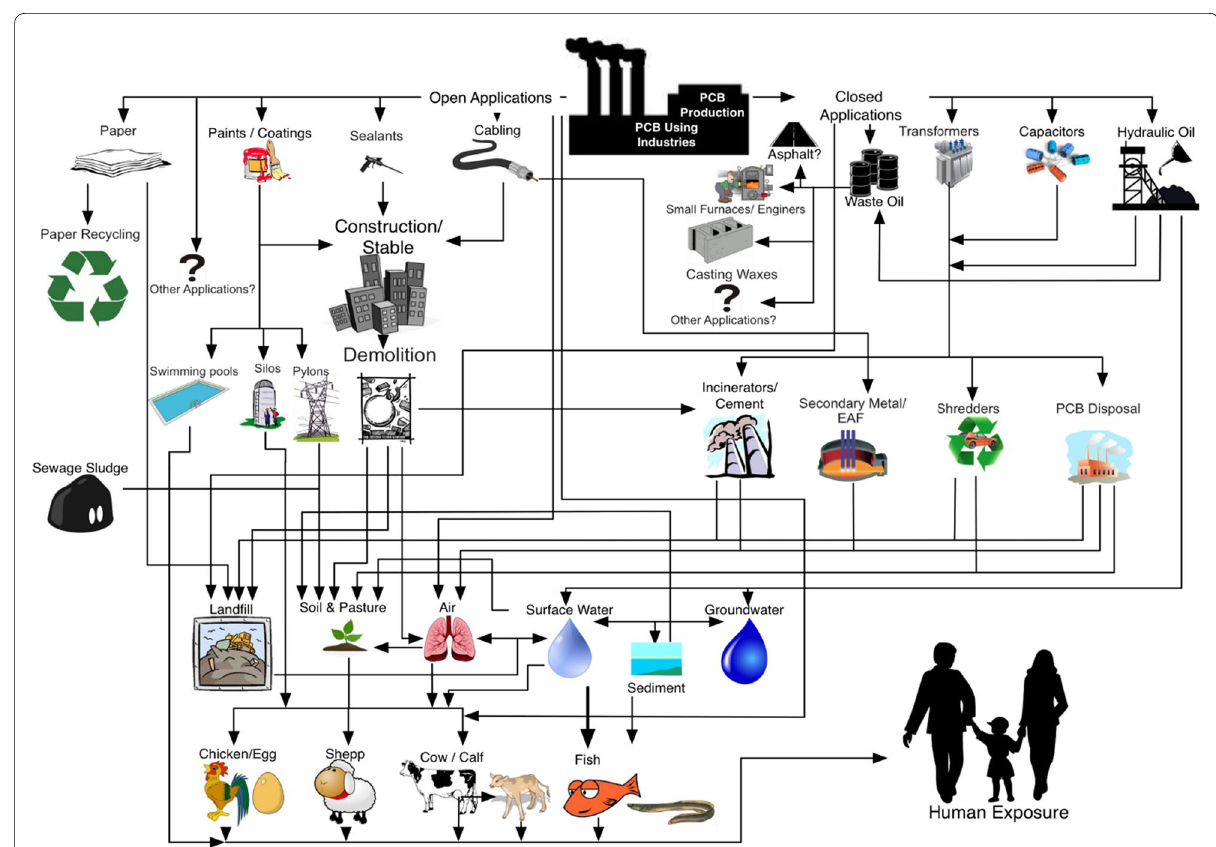
Fig. 5 Life cycle of PCBs showing environmental release sources and exposure pathways for food-producing animals